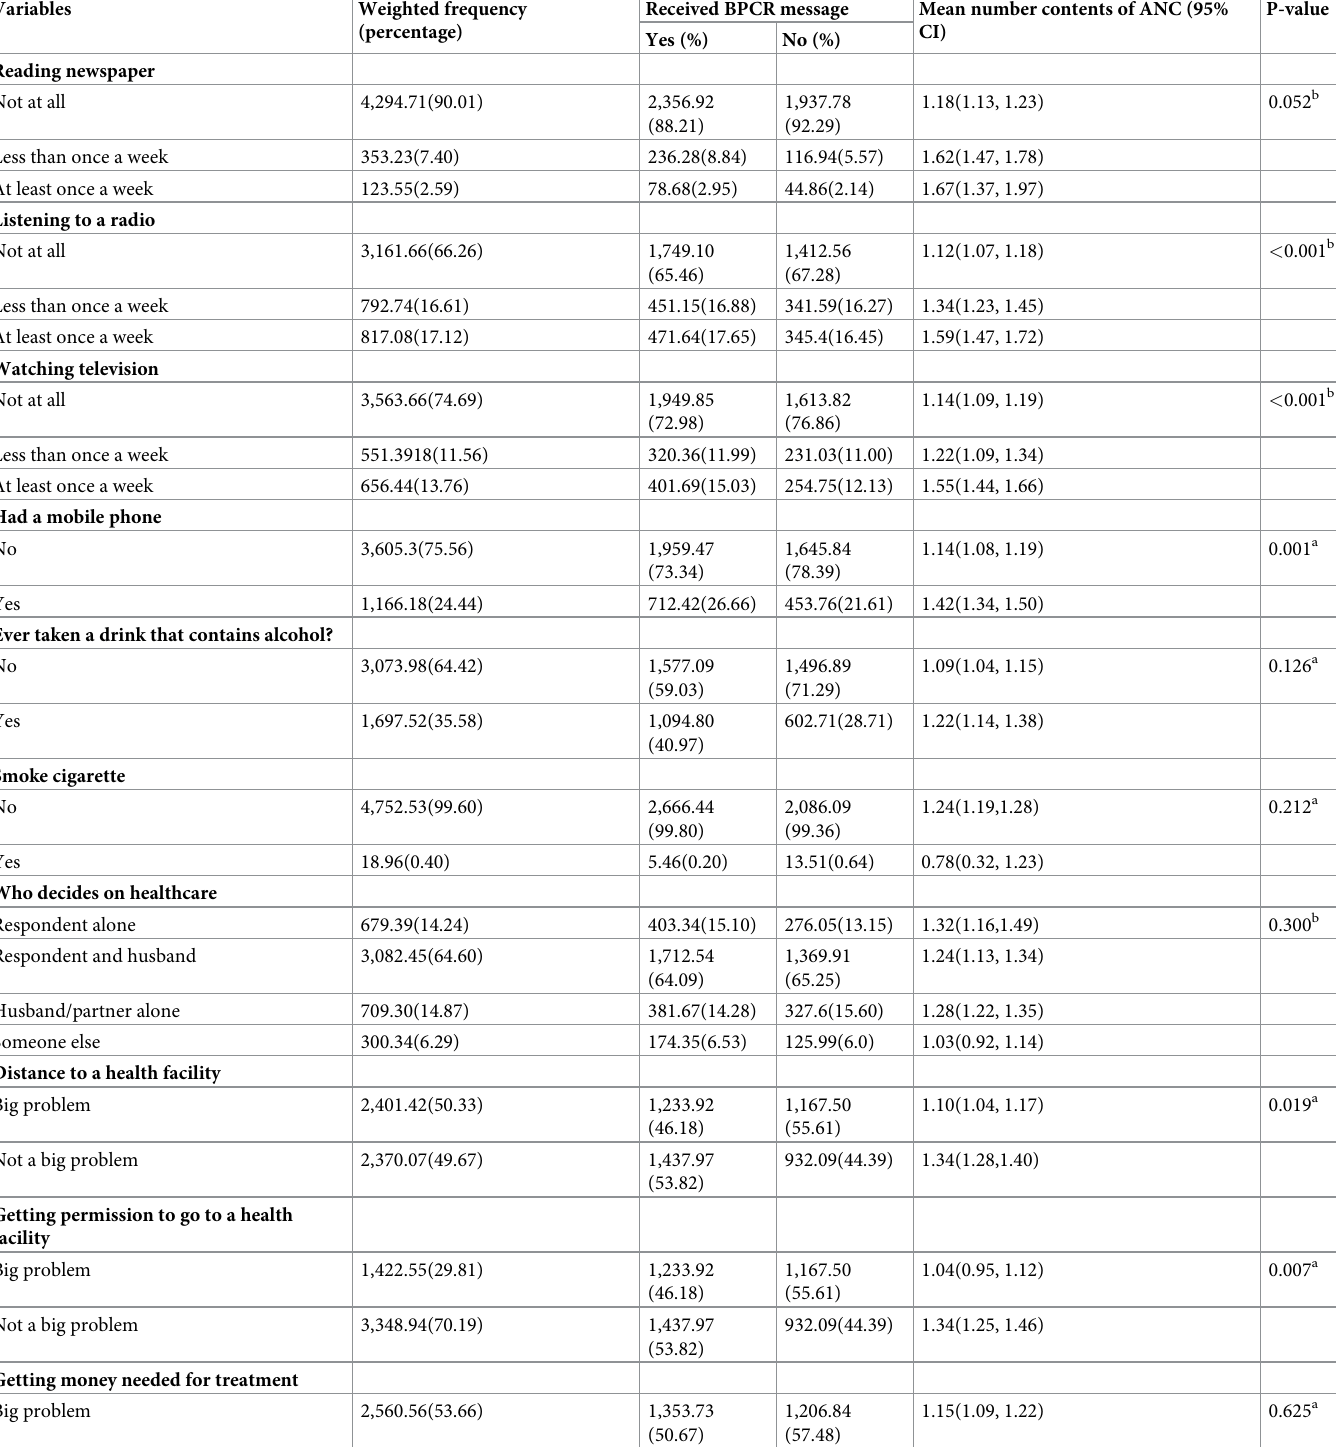
Table 3. The distribution of individual and behavioral characteristics of women in the reproductive age group across the overall uptake and mean number of BPCR messages in Ethiopia,